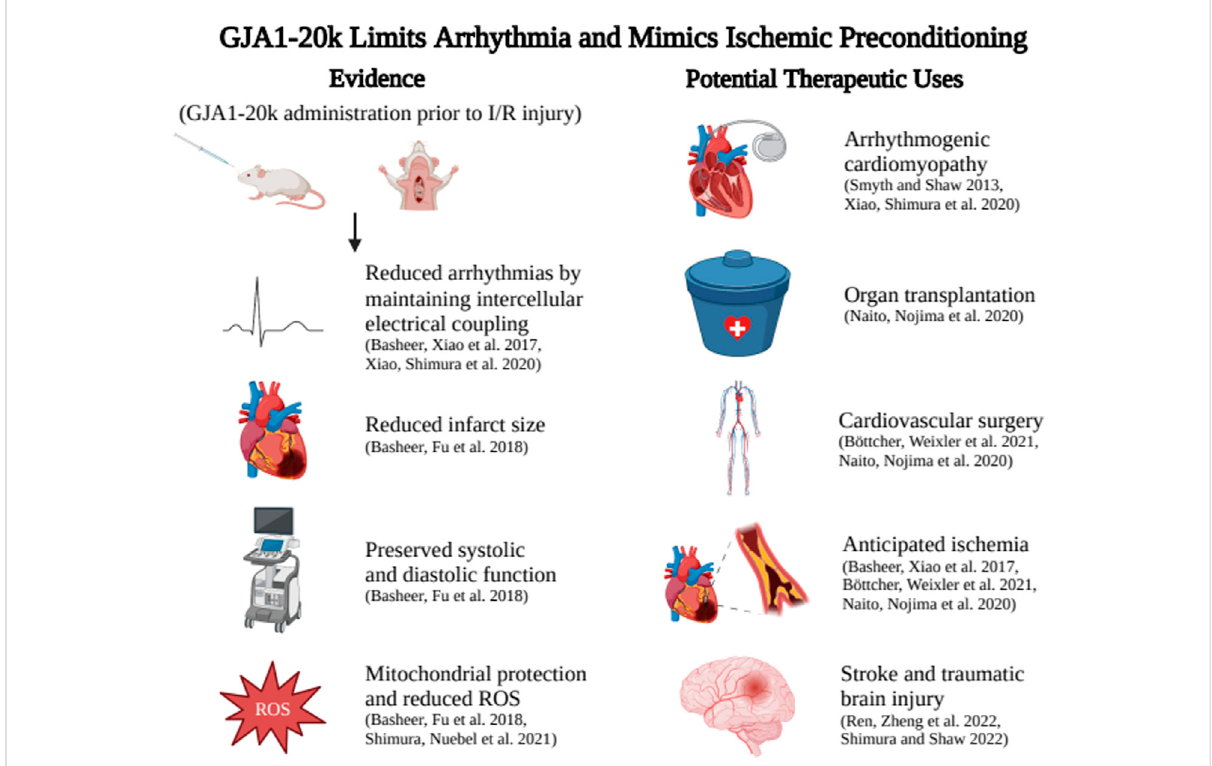
FIGURE 1 GJA1-20kadministrationaidsConnexin43traf fi ckingtoreduceventriculararrhythmiaburdenandalsolimitsanticipatedI/Rinjurybymimicking ischemic preconditioning. Potential therapeutic applications include reducing arrhythmia in genetic or acquired arrhythmia syndromes, preserving organs prior to transplant, pretreatment before angioplasty, cardiac surgery, or other situations of anticipated ischemia or use before anticipated brain injury to reduce the effects of stroke. Created with